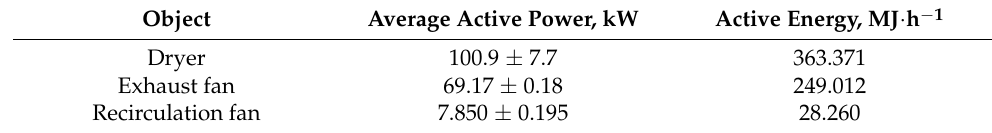
Table 11. Electrical parameters of individual elements of the S428.CS